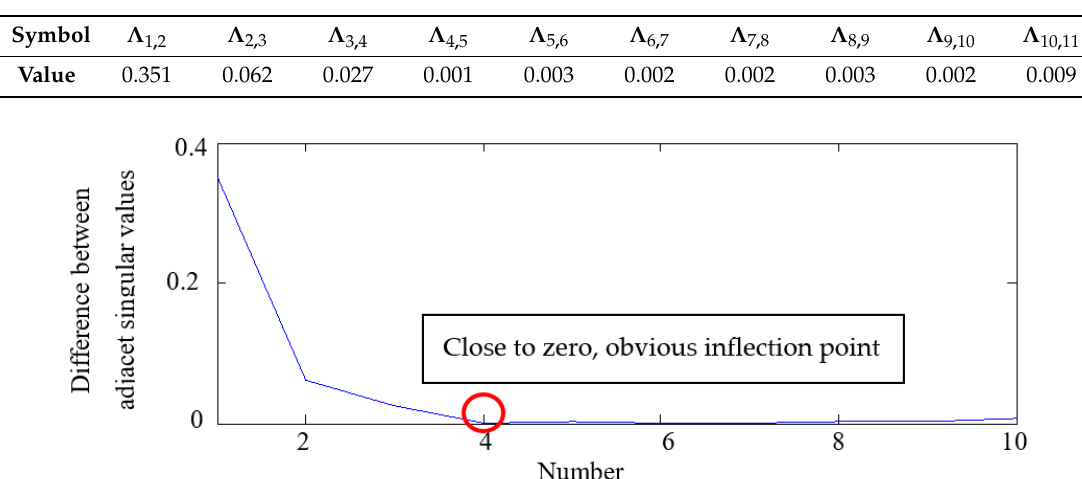
Table 3. Adjacent singular value difference.